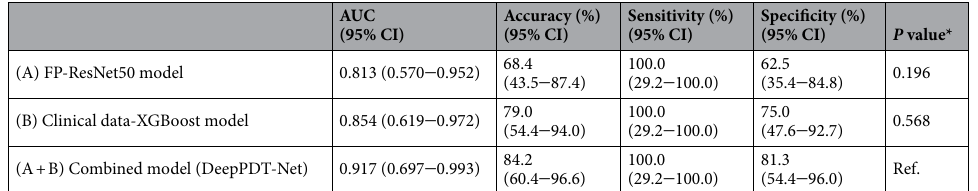
Table 2. Performance of machine learning models for detecting refractory central serous chorioretinopathy cases in the external validation (Gangnam Severance Hospital dataset). AUC Area under the receiver operating characteristic curve, CI Confidence interval. *The AUCs were compared using the DeLong’s method.